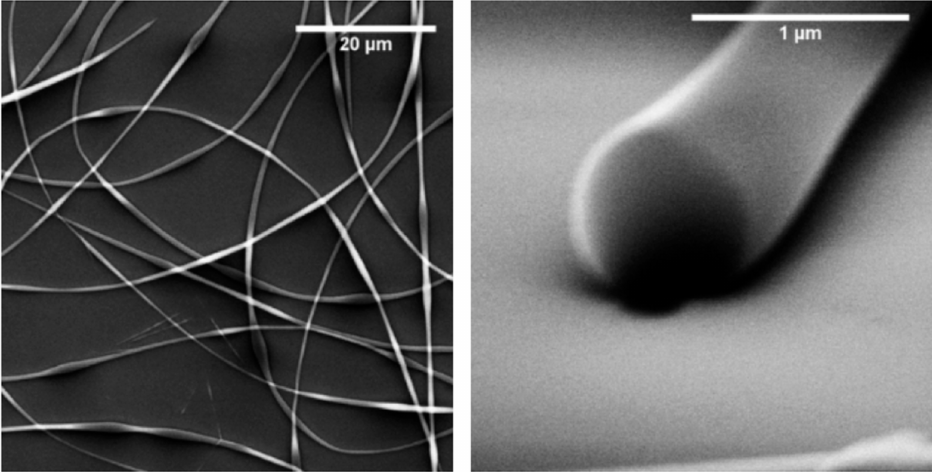
Figure 8. SEM images of electrospun fibers of compound 3 . Reproduced from [27] with permission from The Royal Society of